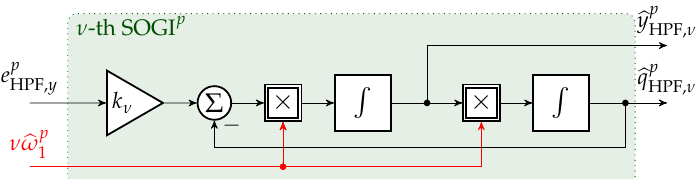
Figure 2. Block diagram of a Second-Order Generalized Integrator (SOGI) for the detection of the ν -th harmonic